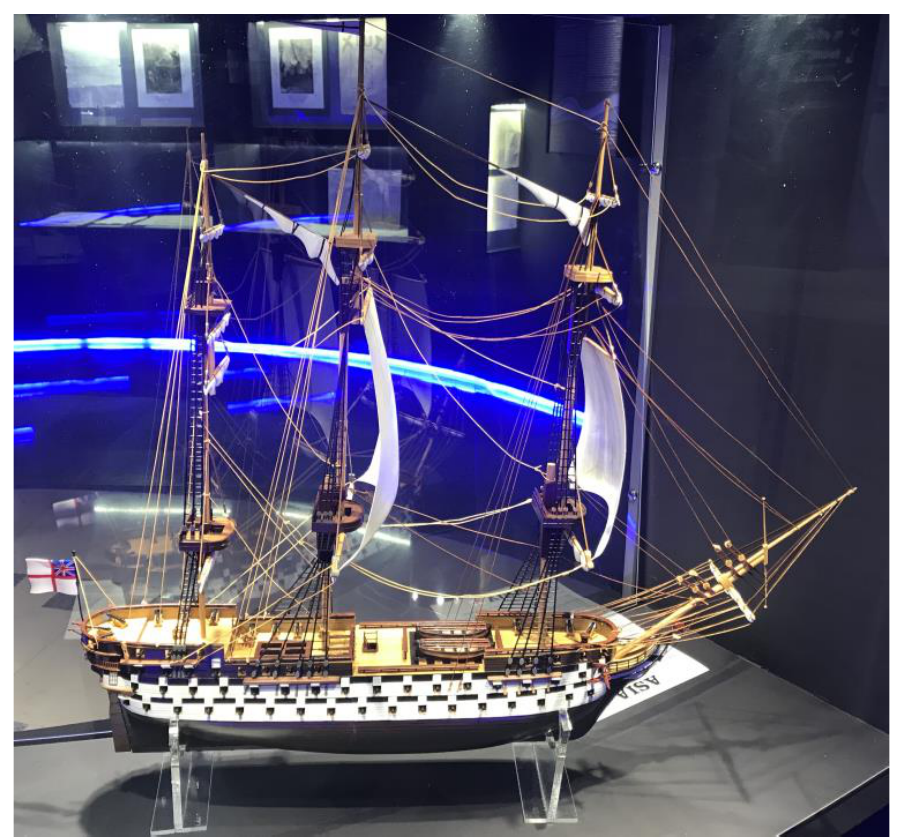
Figure 24 . Asia 3D-printed model after painting process.